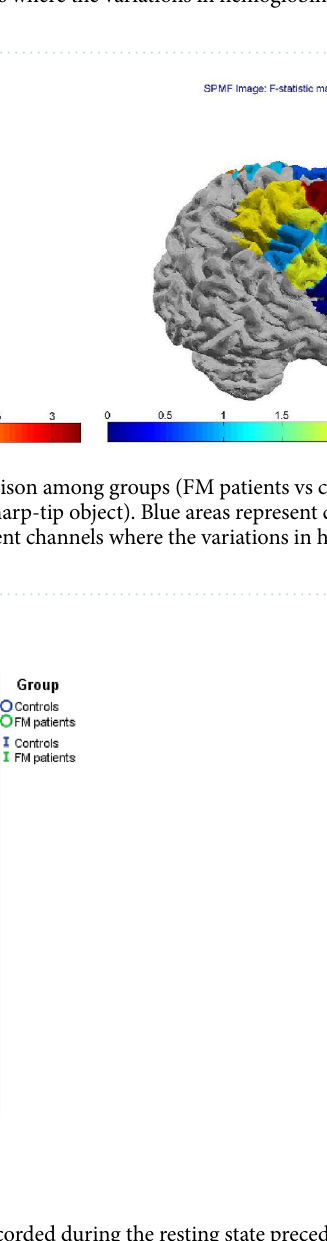
Figure 8. Mean and 95% CI of oxyhemoglobin levels recorded during the resting state preceding the time- to-contact detection session and the resting state preceding the observation-only session in a representative channel (channel